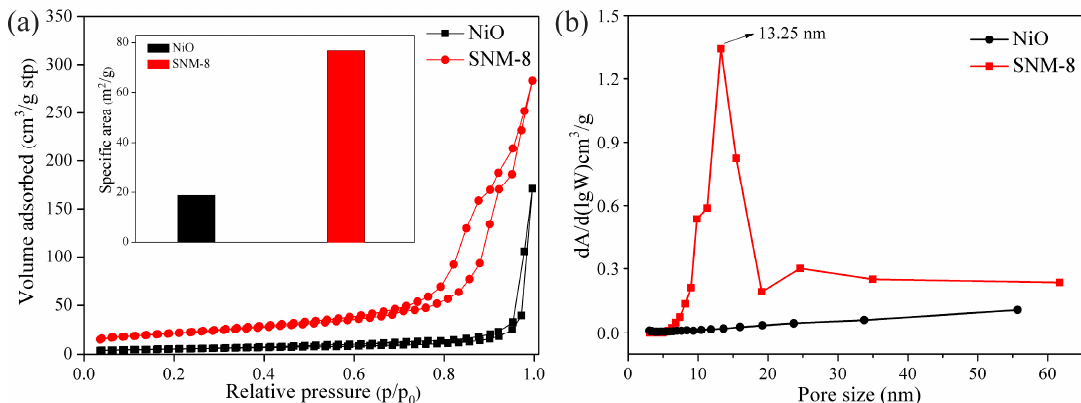
Figure 6. ( a ) N 2 adsorption-desorption isotherms of the NiO and SNM-8 samples, and the inset is the corresponding BET specific surface areas of the NiO and SNM-8 samples; ( b ) Pore size distribution curves of the NiO and SNM-8 samples.